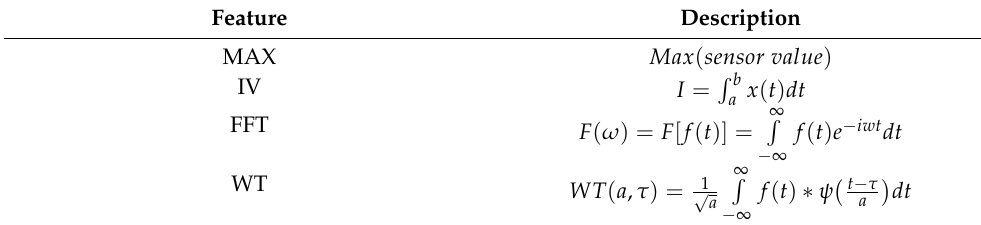
Table 3. The description of features.